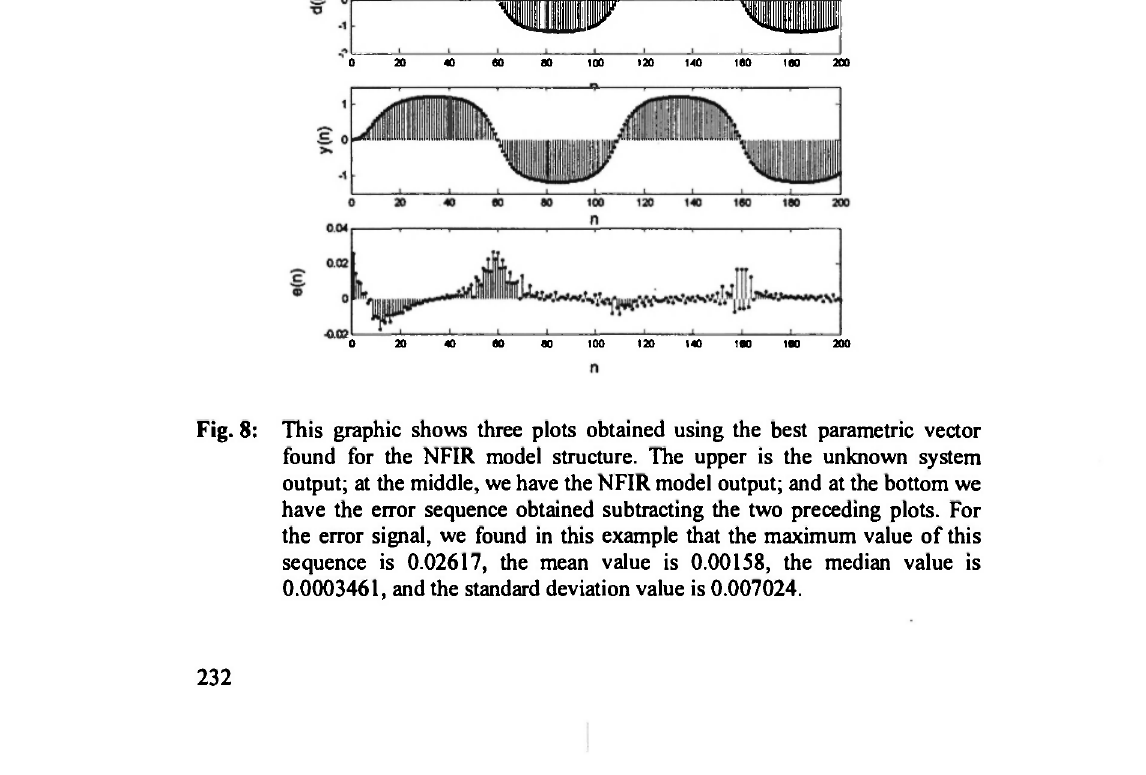
Fig. 7: Validation data. We used a noisy sinusoidal sequence as the input to both systems (solid line), the system's output at the adaptive model side is shown with a dashed line